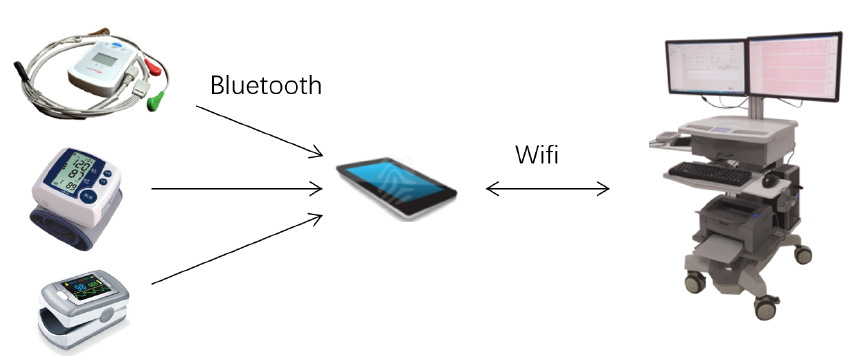
Figure 1. The cardiac chronotropic competence test (3CT) consists of a wearable device ( top left ), a smartphone app, and a workstation. Blood pressure meter and SpO2 meter ( bottom left ) are used to measure blood pressure and SpO2 before and after the